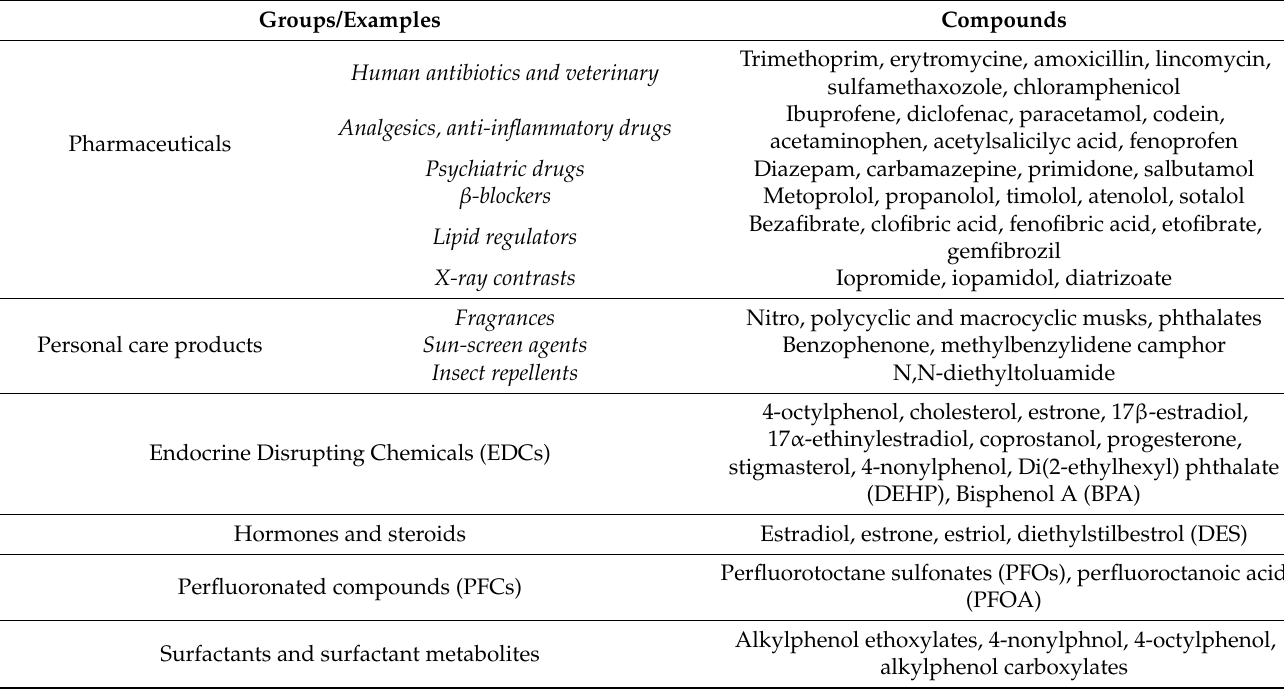
Table 1. Emerging pollutants groups and their major compounds [9–11] (Reprinted by